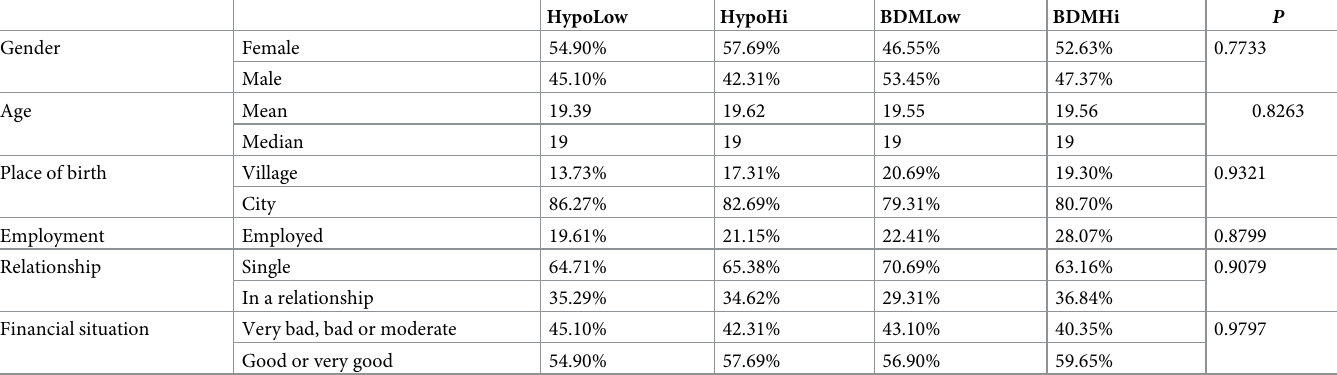
Table 1. Experiment 1: Comparison of respondents’ characteristics across all